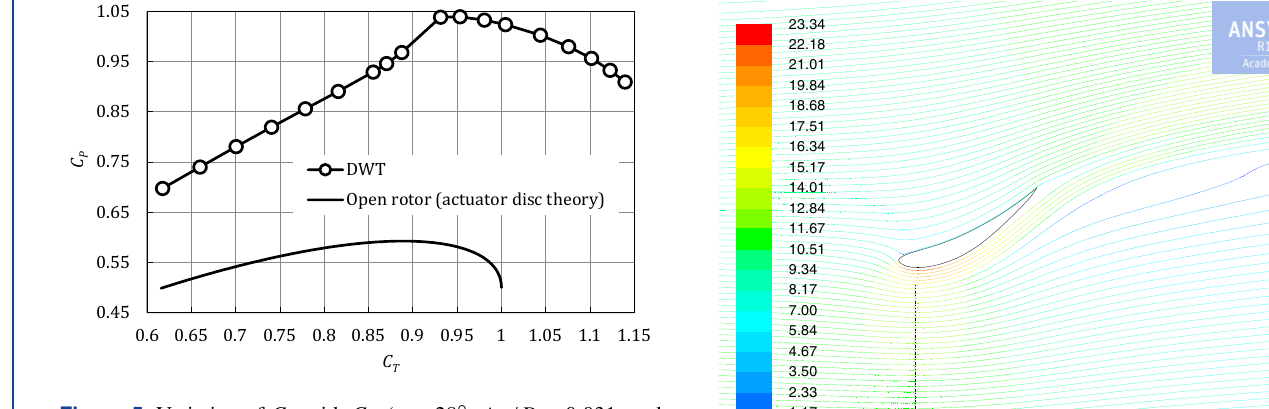
Figure 5. Variation of C P with C T ( α = 28 ◦ ; (cid:49)r/D = 0 . 031; and z/c = 0 . 103).